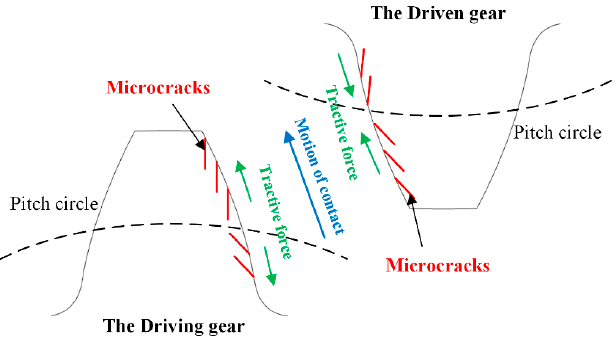
Figure 12. The correlation between the micropitting crack propagation direction and the gear sliding/rolling condition (Reprinted with permission from [85,93]. Copyright 2005 SAGE & 2012 Gear Technology).